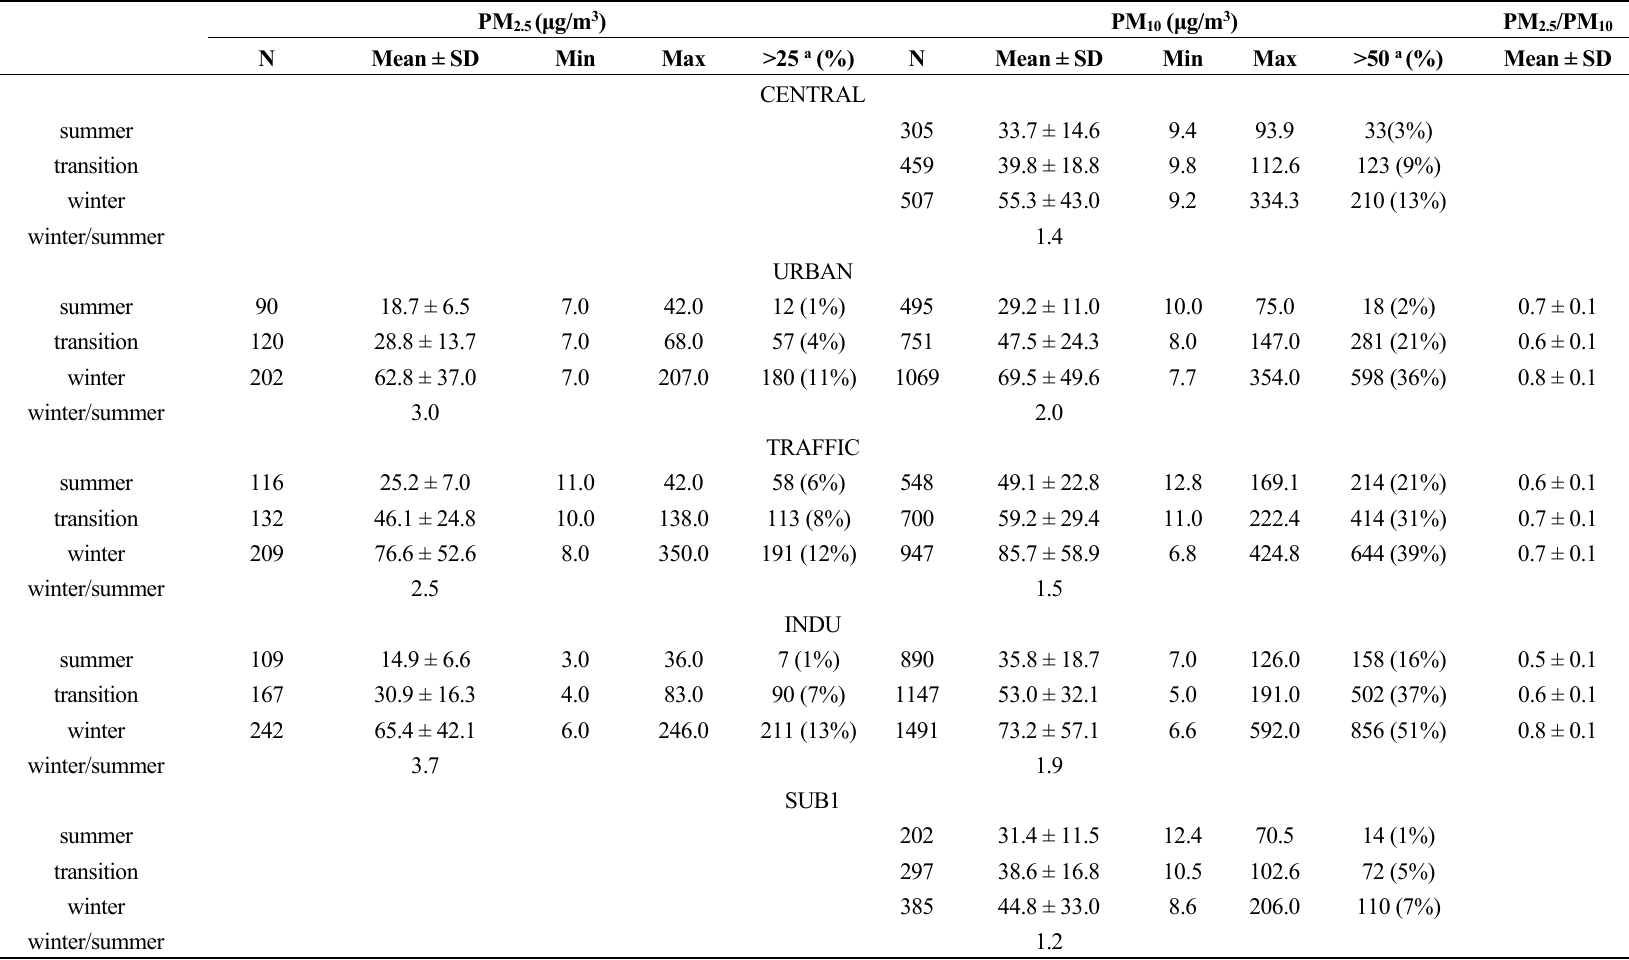
Table 1. Concentration distributions for PM 10 (years 2000  2010) and PM 2.5 (years 2009–2010). a refers to the number of days that exceeded the current EU